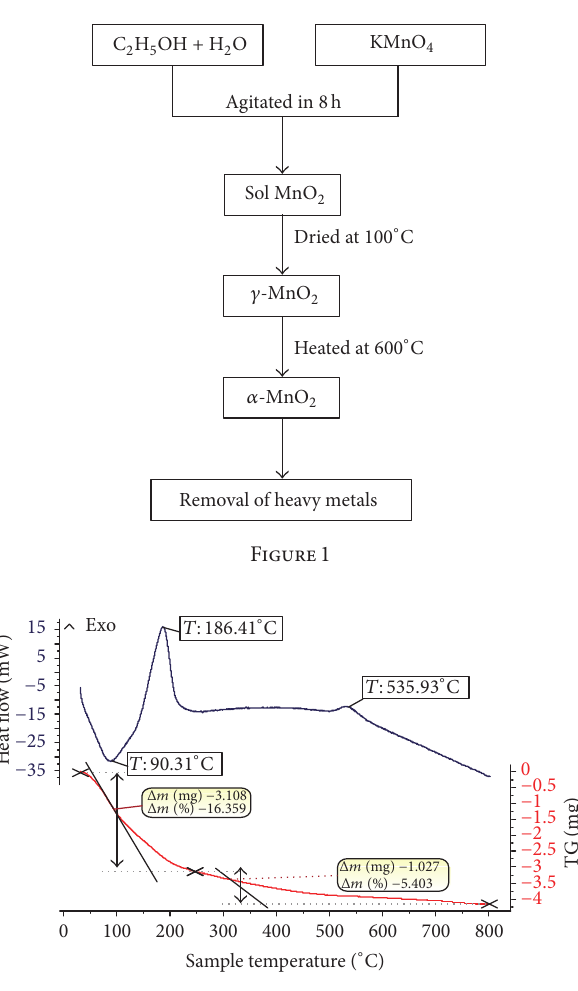
Figure 2: TG-DTA